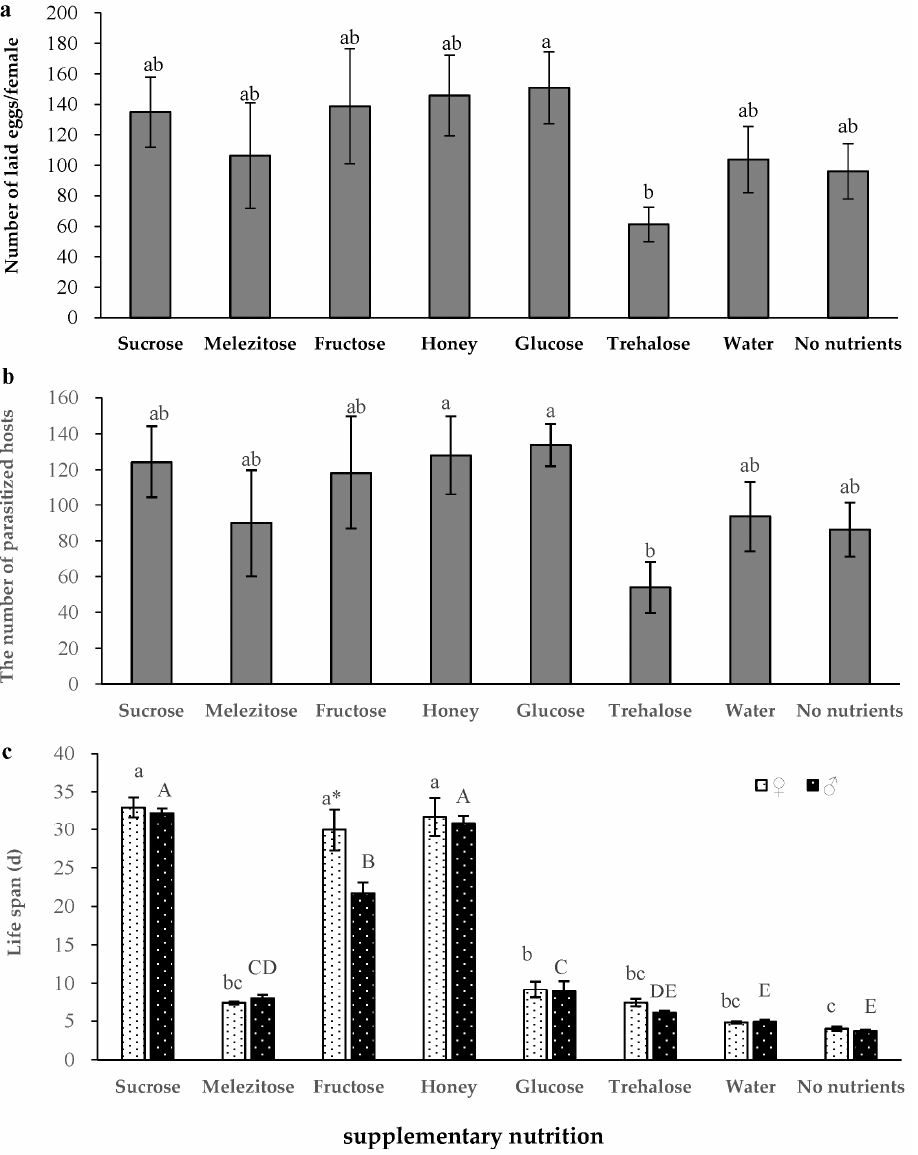
Figure 3. Effects of supplementary nutrition on the development and reproduction of S. caerulea . ( a ) Number of eggs laid (the eggs were laid by each female throughout their entire lifespan). ( b ) Number of hosts parasitized. ( c ) Adult life span. means ± standard errors, the different letters indicate significant differences amongst the supplementary nutrition (female, capital letters; male, lowercase letters) ( p < 0.05), and * indicates significant differences between females and males having the same supplementary nutrition ( p < 0.05).